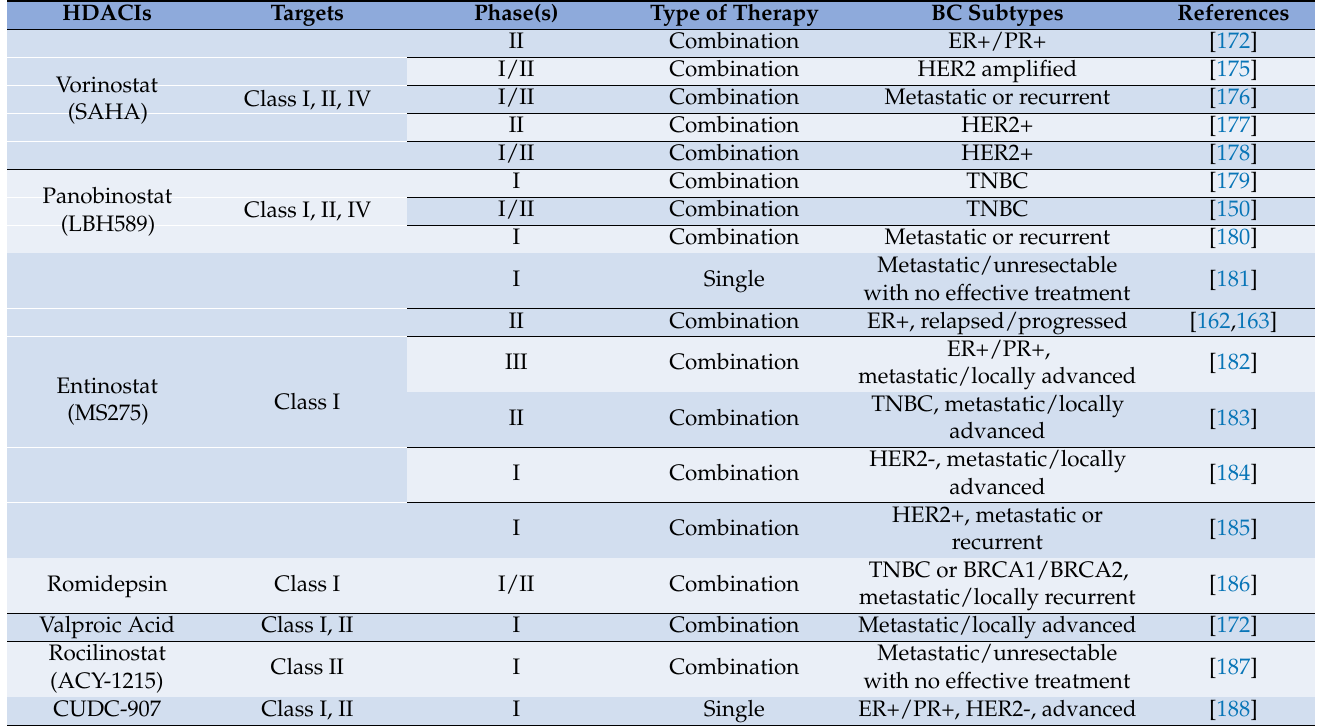
Table 2. A variety of HDACIs at different phases of BC clinical